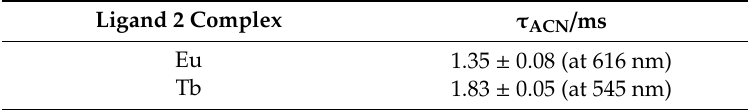
Table 5. Emission lifetimes for 1:1 complexes of Eu(NO 3 ) 3 and Tb(NO 3 ) 3 with ligand 2 in acetonitrile. The error bars on these numbers represent the standard deviation from three